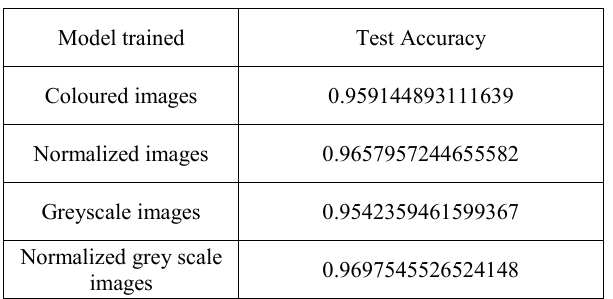
Fig. 19. loss of normalized grey scale images. Table 1. depicts the trained model and test accuracy data. Table 1. Trained model and test accuracy.